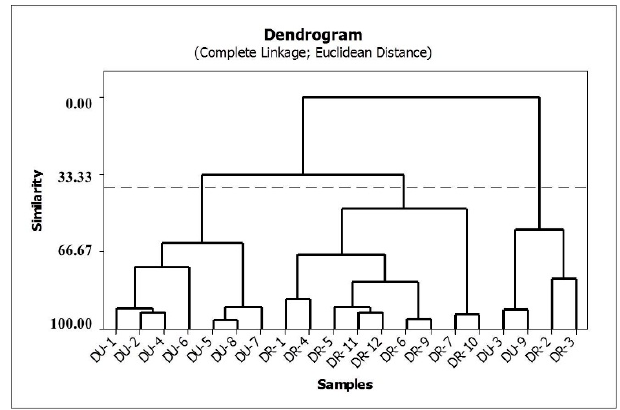
Figure 4. Dendrogram of similarities between production of rotenone and deguelin in the species.